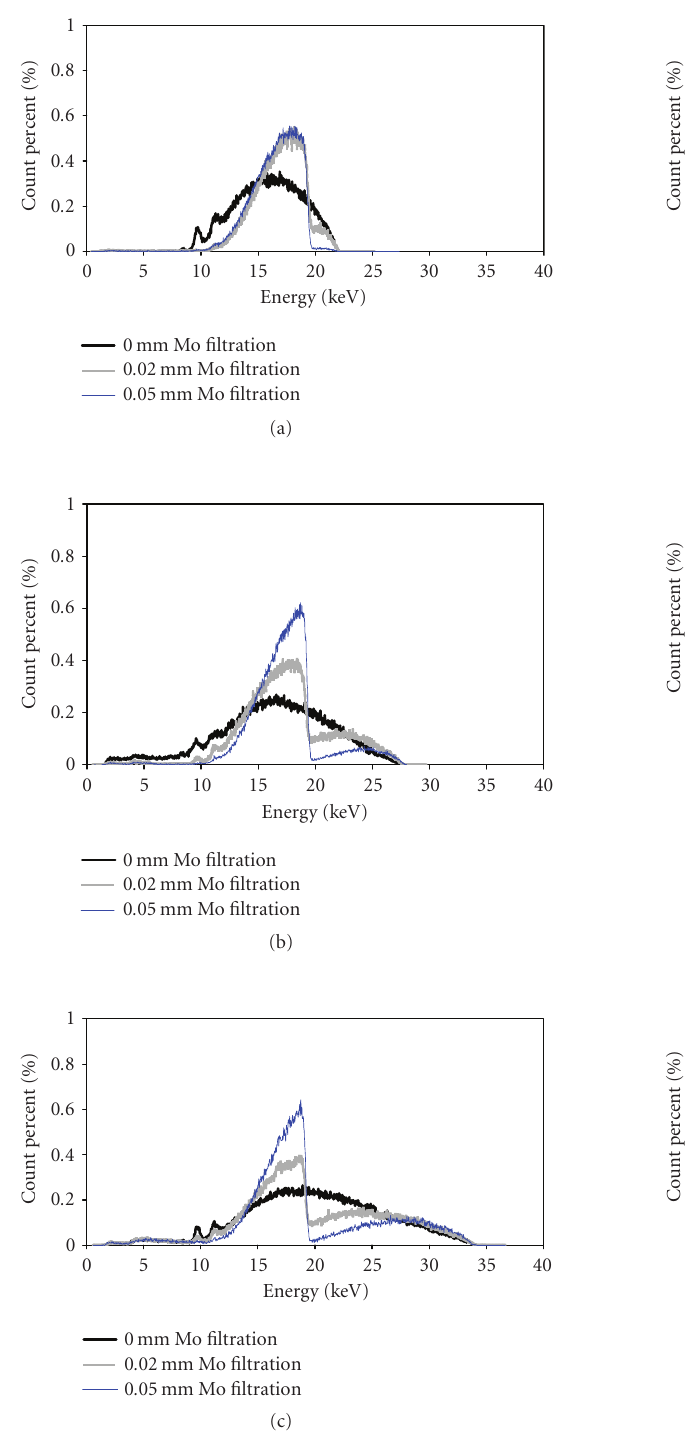
Figure 3: (a) X-ray spectra using the 1 . 15 cm phantom under the exposure of 22 kVp with a 0 . 0cm (thick curve), 0 . 02cm (gray curve), and 0 . 05 cm (thin curve) Mo filter. (b) X-ray spectra using the 1 . 15 cm phantom under the exposure of 28kVp with a 0 . 0cm (thick curve), 0 . 02 cm (gray curve), and 0 . 05 cm (thin curve) Mo filter. (c) X-ray spectra using the 1 . 15 cm phantom under the ex- posure of 35kVp with a 0 . 0 cm (thick curve), 0 . 02 cm (gray curve), and 0 . 05cm (thin curve) Mo filter.